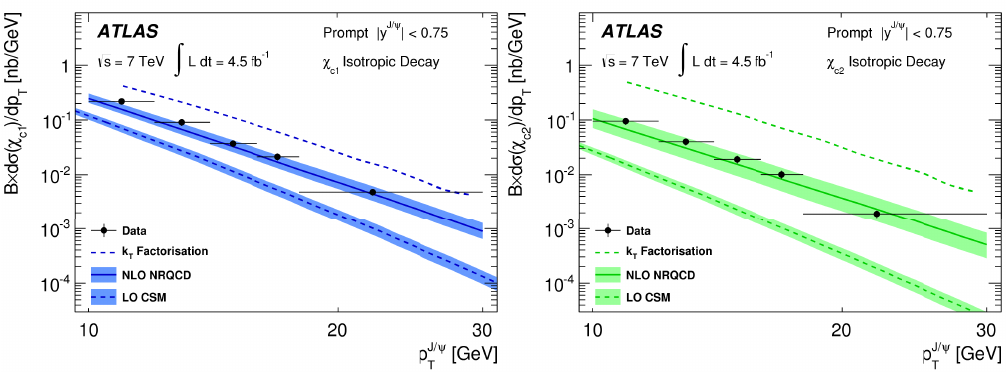
Figure 3: Di ff erential cross-sections for prompt χ c 1 (left) and χ c 2 (right) production.